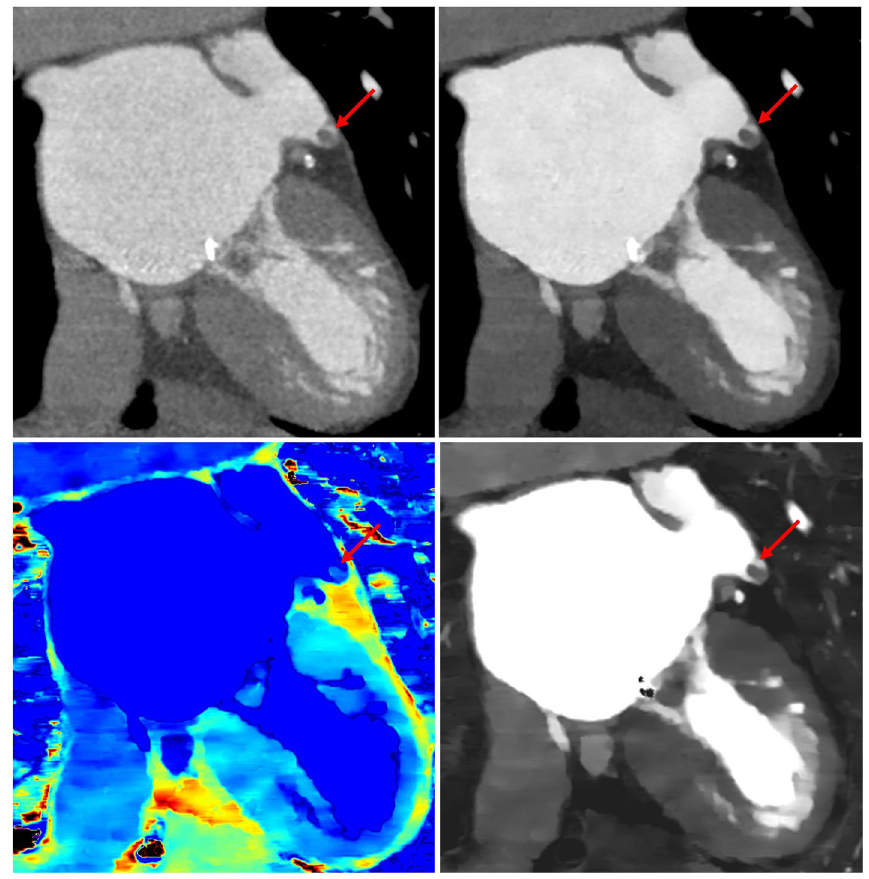
Figure 2. 5 mm thrombus in the left atrial appendage (arrows) on conventional (top left), virtual 55 keV monoenergetic (top right), z-effective (bottom left), and iodine density images (bottom right).